Question: Does the figure show an increasing or a decreasing trend?
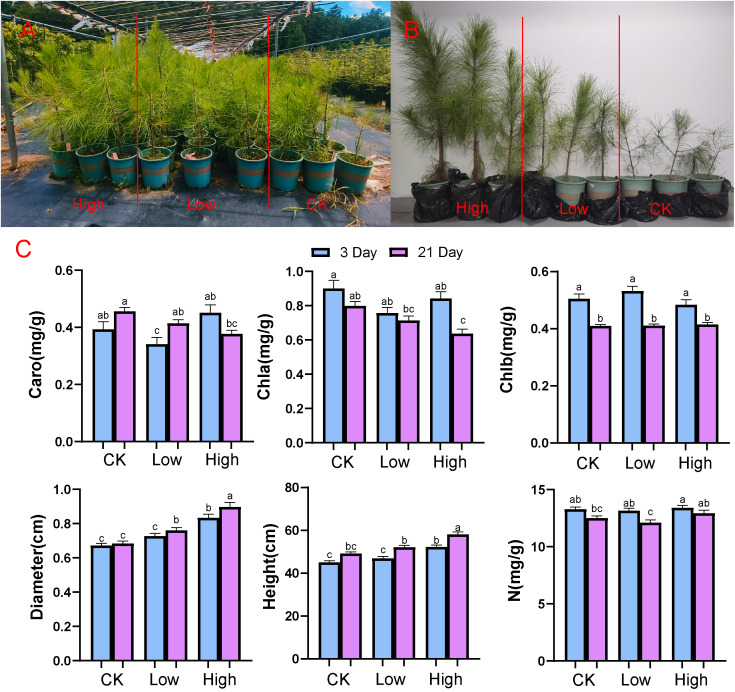
Answer: increasing